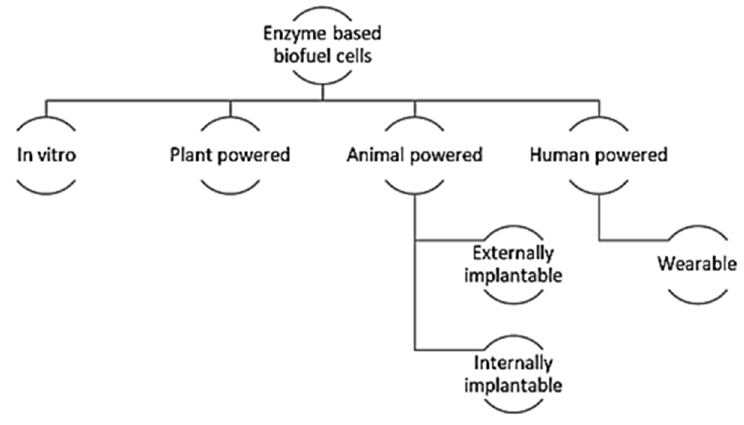
Figure 13. Classifying EBFCs according to their placement.